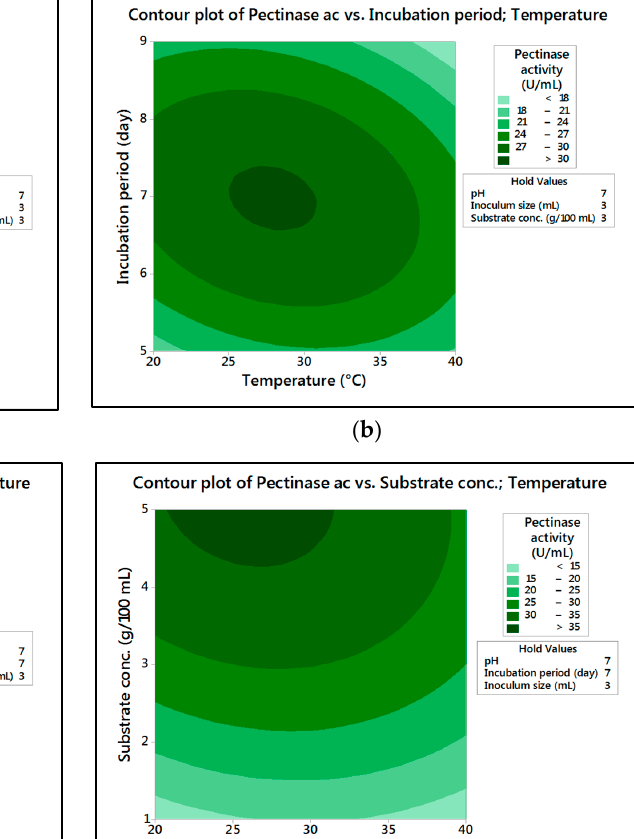
Figure 5. Contour plot showing interactions between independent variables: ( a ) incubation tem- perature with pH; ( b ) incubation temperature with incubation period; ( c ) incubation temperature with inoculum size; ( d ) incubation temperature with substrate concentration; ( e ) pH with incubation period; ( f ) pH with inoculum size; ( g ) pH with substrate concentration; ( h ) incubation period with inoculum size; ( i ) incubation period with substrate concentration; ( j ) inoculum size with substrate concentration for pectinase activity produced by M. circinelloides .